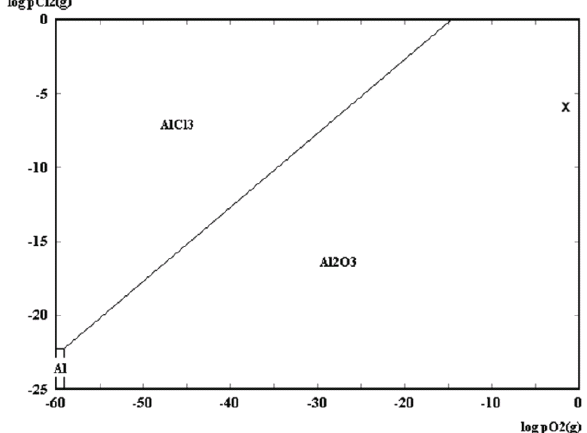
Figure 1. Al-O-Cl phase stability diagram at 833 K. Equi- librium composition of experiment 1 is marked with